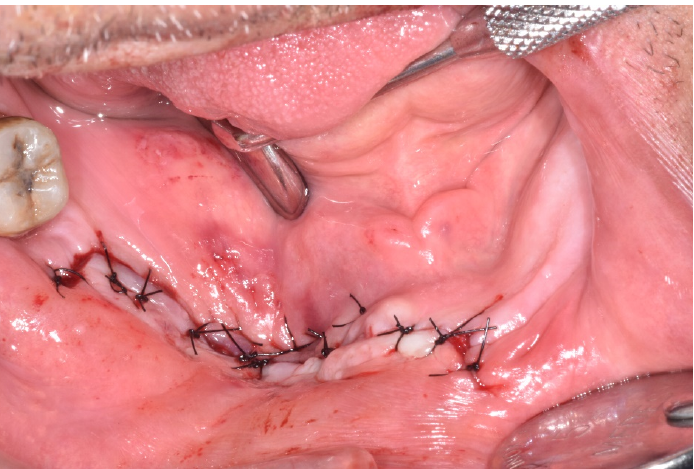
. . . . Figure 5. Healthy bleeding bone surface. Figure 5. Healthy bleeding bone surface. Figure 5. Healthy bleeding bone surface.